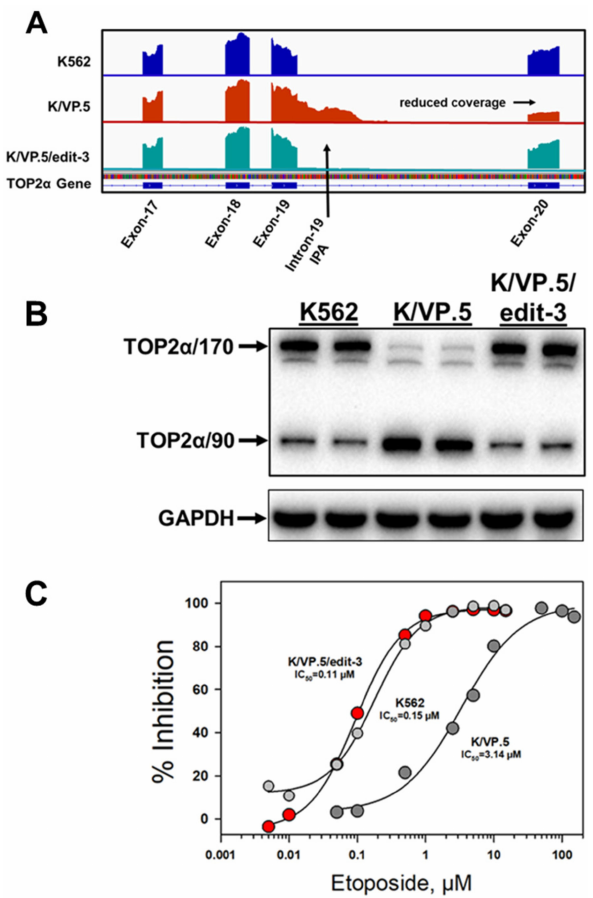
Figure 10. Effects of optimizing the TOP2 α intron 19 5 (cid:48) SS in K/VP.5 cells by CRISPR/Cas9/HDR editing. ( A ) RNA-seq genome coverage tracks for TOP2 α showing the intron 19 IPA event in K/VP.5 cells and the restoration of intron removal in K/VP.5/edit-3 cells. Reduced coverage in exon 20 in K/VP.5 cells is consistent with fewer full-length TOP2 α /170 reads while greater exon 20 coverage